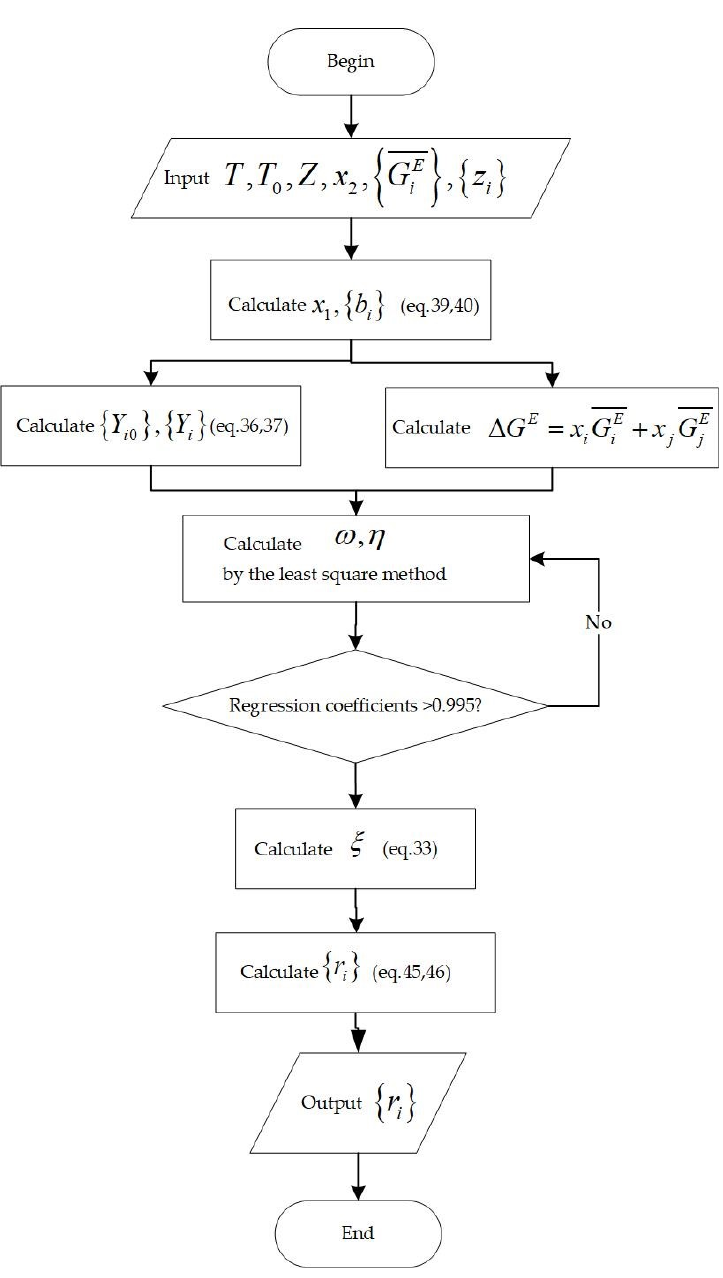
Figure 6. Flowchart for the calculation of activity coefficients.